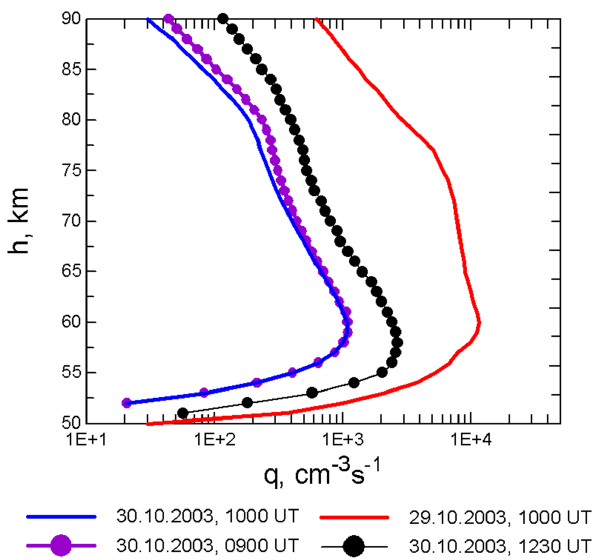
Fig. 9. Comparison of the ionisation rates on 29 October at 10:00UT and on 30 October at 09:00, 10:00 and 12:30UT.